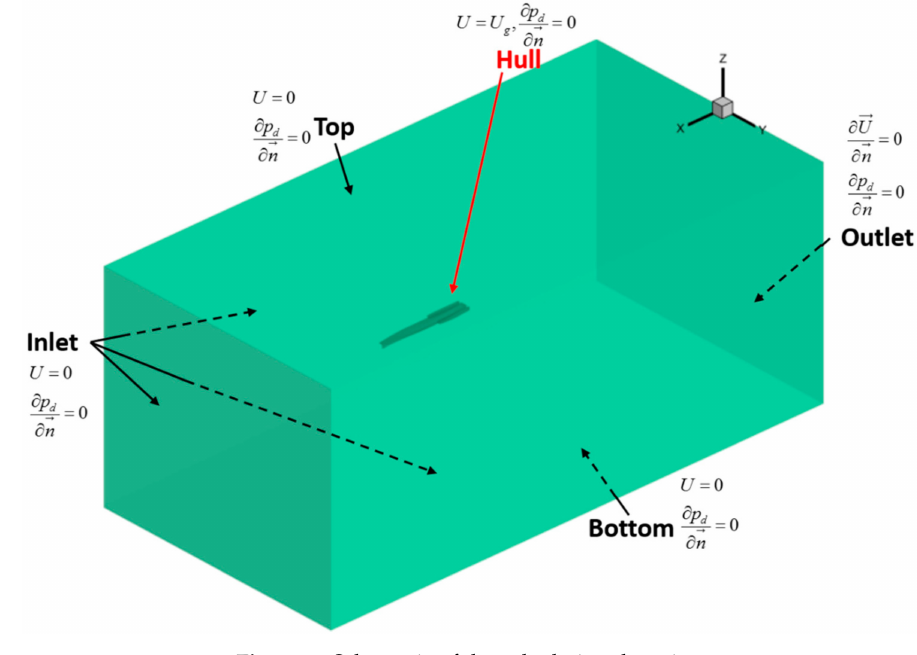
Figure 1. Schematic of the calculation domains. Table 2. Boundary